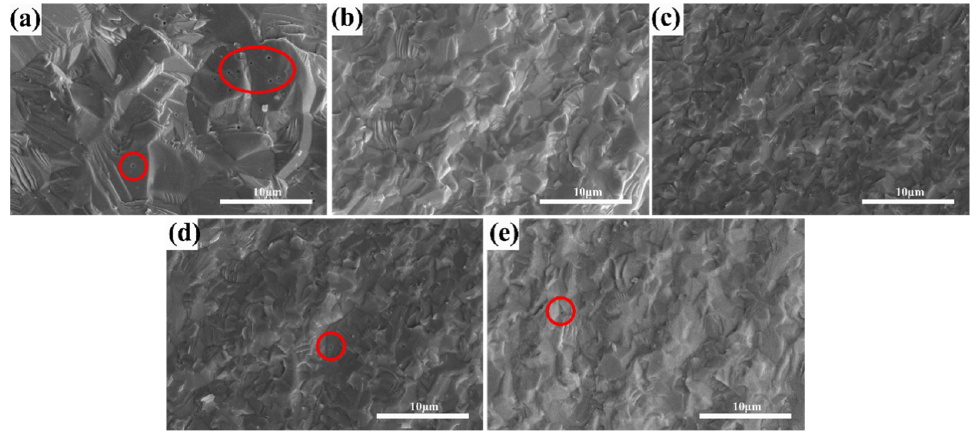
Figure 5. SEM micrographs of the fractured surfaces of the (Tb 0.7 Lu 0.3 ) 2 O 3 ceramics after 1575 °C hot isostatic pressing sintering with varying ZrO 2 contents (The pores were marked in red circles) : ( a ) 0 at%, ( b ) 2 at%, ( c ) 3 at%, ( d ) 4 at%, ( e ) 5 at%.